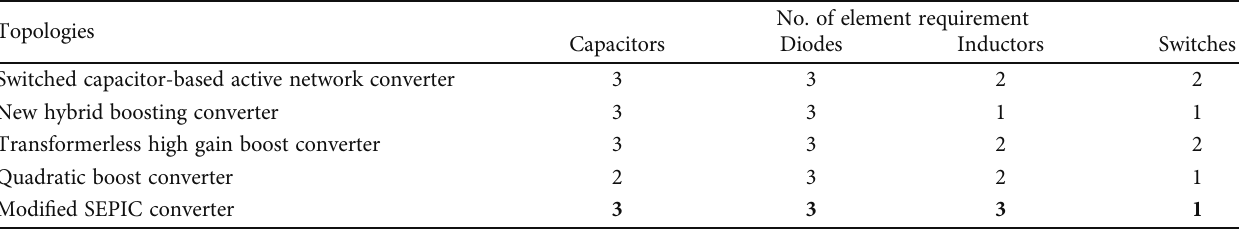
Table 2: Contrast among MSC with conventional nonisolated high gain DC-DC converter topologies. Topologies